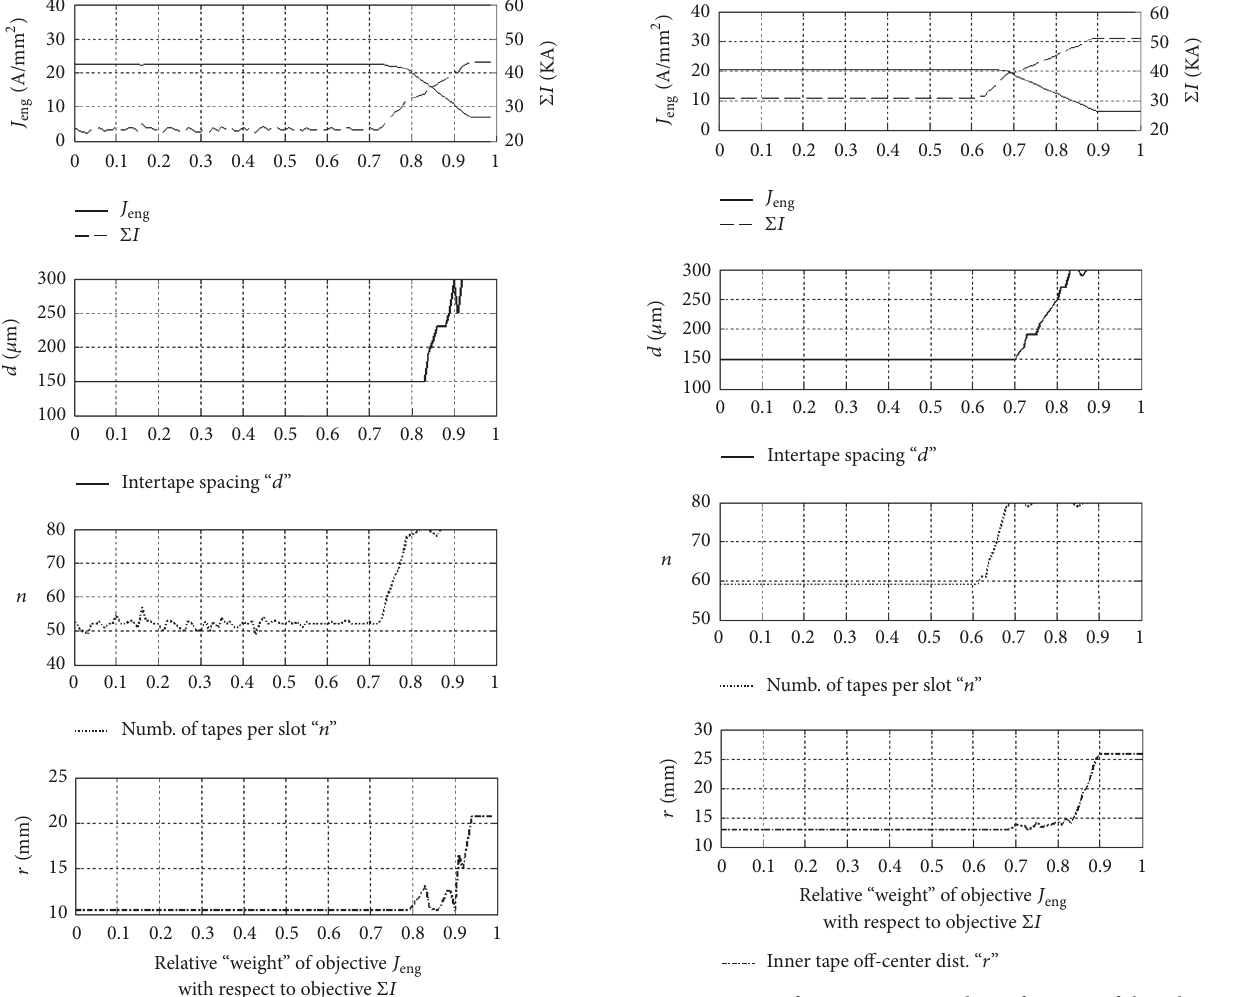
Figure 9: Pareto frontier represented as a function of the relative “weight” of one objective with respect to the other for the 5 slots’ = 5) . Top panel: values of the two objectives. configuration (𝑛 slots Bottom panels: values of the respective design variables.